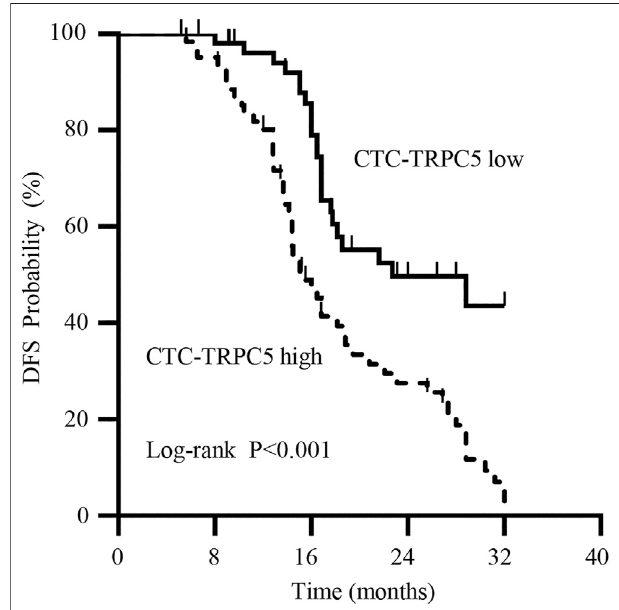
FIGURE 5 | Kaplan-Meier survival curve showing a statistically longer median DFS in radical resected CRC patients with high CTC-TRPC5 expression than with those with low CTC-TRPC5 expression.